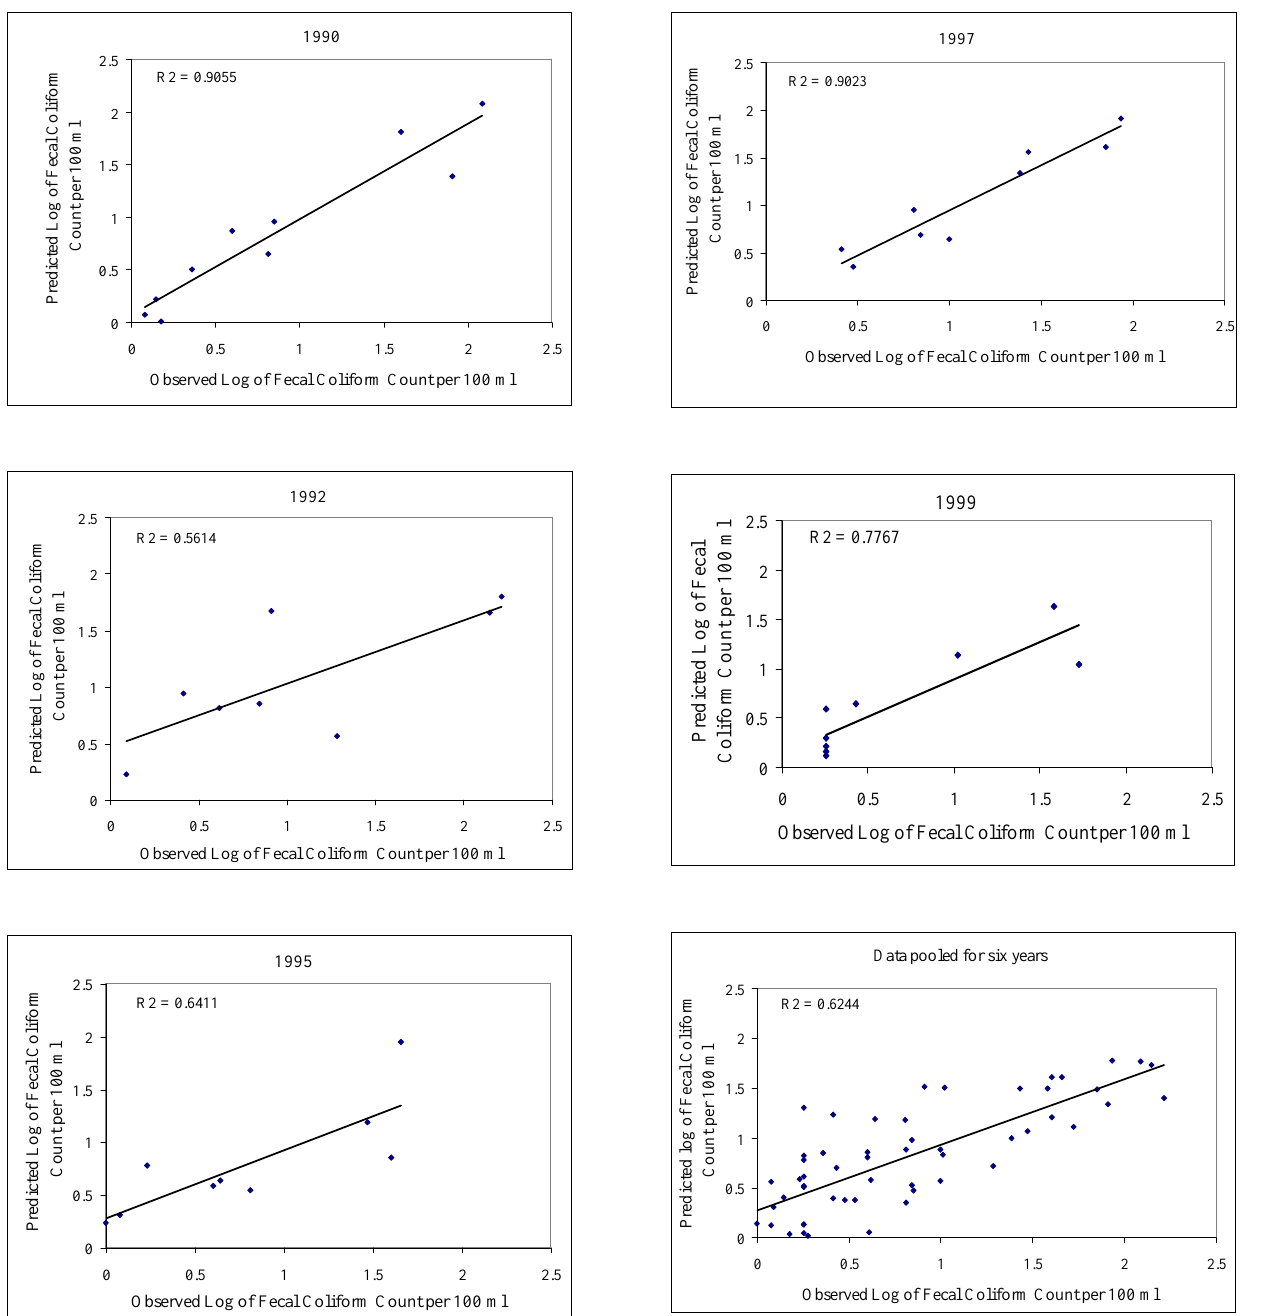
Figure 6: Plot of the predicted log of fecal coliform counts against observed log of fecal coliform counts for various